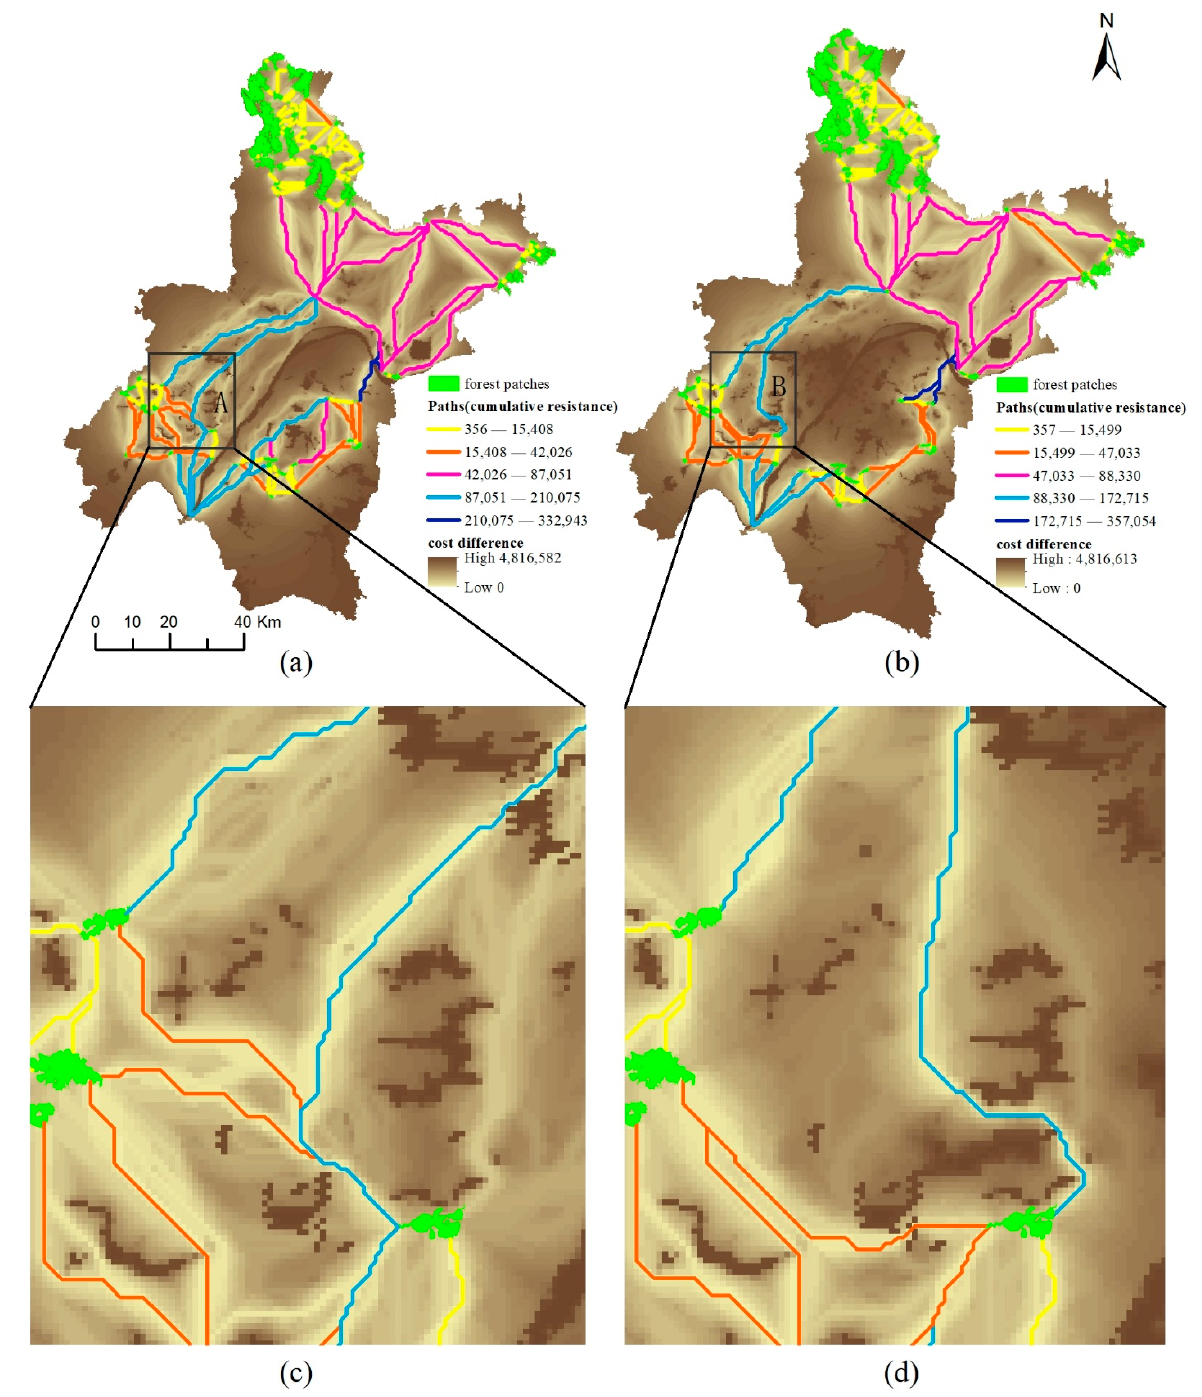
Figure 5. ( a ) Paths from RNDVI; ( b ) paths from RNAVI; ( c ) magnified area A; ( d ) magnified area B. Notes: Cost difference means the minimum difference in the cost of passing a certain cell compared with the least-cost paths.